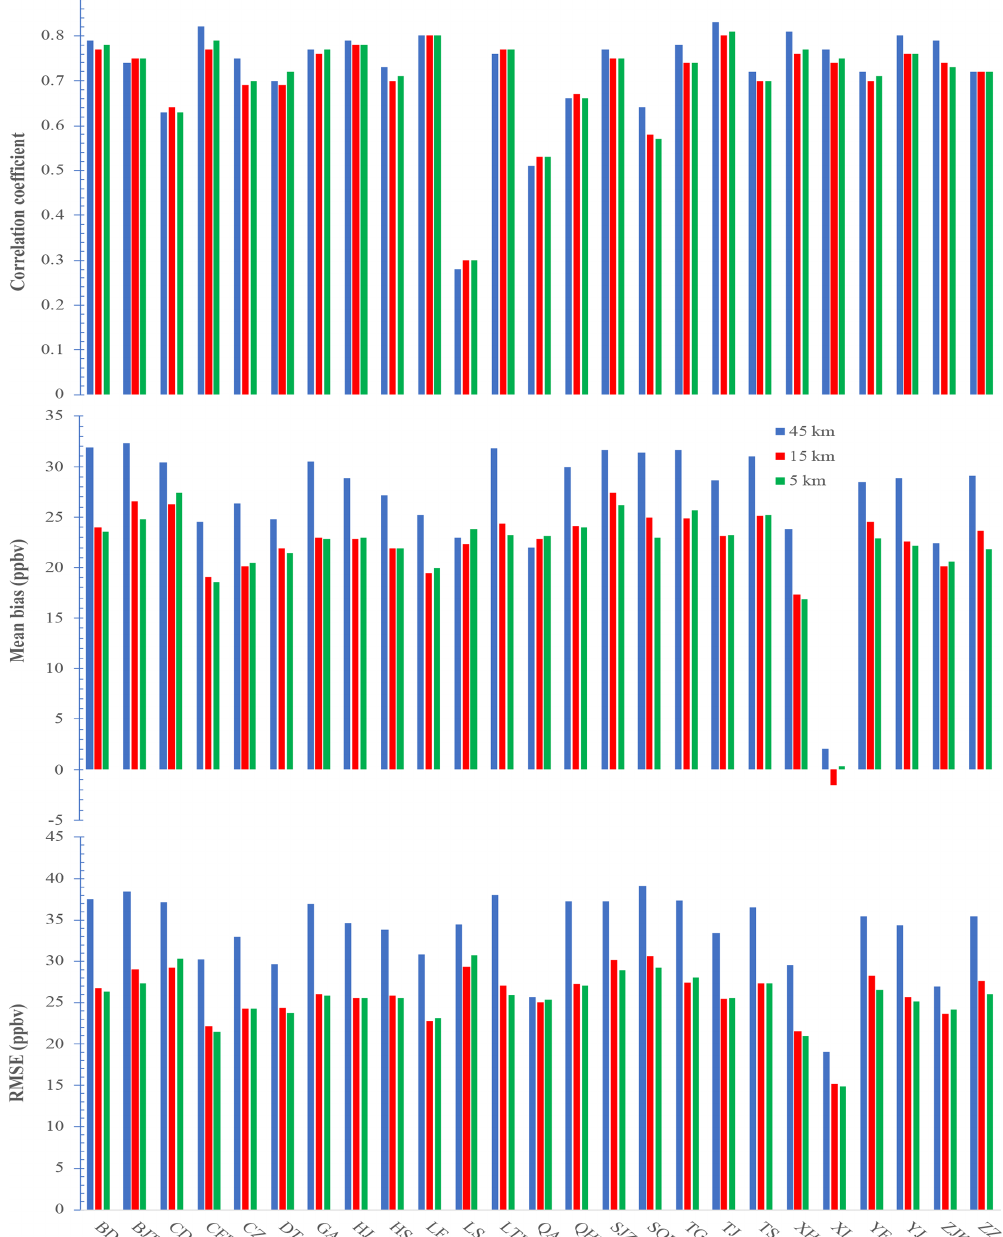
Figure 3. Comparisons of MB, RMSE, and correlation coefficient r of surface O 3 from different horizontal resolutions at each air quality monitoring site for the year of